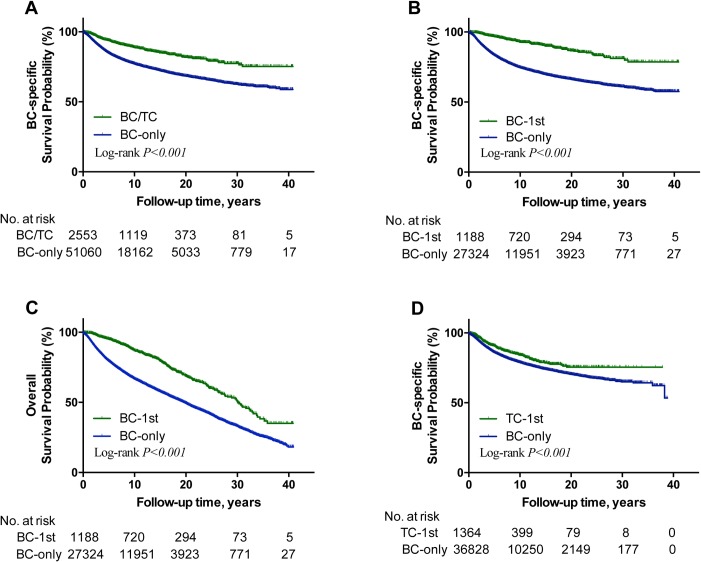
Kaplan-Meier analysis of the effect of a history of TC on BC-specific and overall survivals of patients in various settings.A, comparison of BC-specific survival curves between BC/TC and matched BC-only patients; B, comparison of BC-specific survival curves between BC-1st and matched BC-only patients; C, comparison of overall survival curves between BC-1st and matched BC-only patients. D, comparison of BC-specific survival curves between TC-1st and matched BC-only patients. BC, breast cancer; TC, thyroid cancer; BC-only, patients only with a diagnosis of breast cancer and without a history of thyroid cancer; BC/TC, breast cancer patients also with a history of thyroid cancer diagnosed any time—either before or after the diagnosis of breast cancer; BC-1st, breast cancer was diagnosed first, followed by the diagnosis of thyroid cancer; TC-1st, thyroid cancer was diagnosed first, followed by the diagnosis of breast cancer.